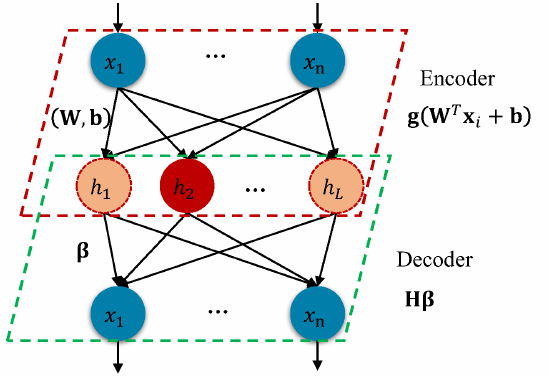
Figure 2. Structure of EMO-ELM which consists of an encoder (red rhomboid box) and decoder (green rhomboid box). Where the red neurons in hidden layer denote they are activated while the orange neurons represent they are